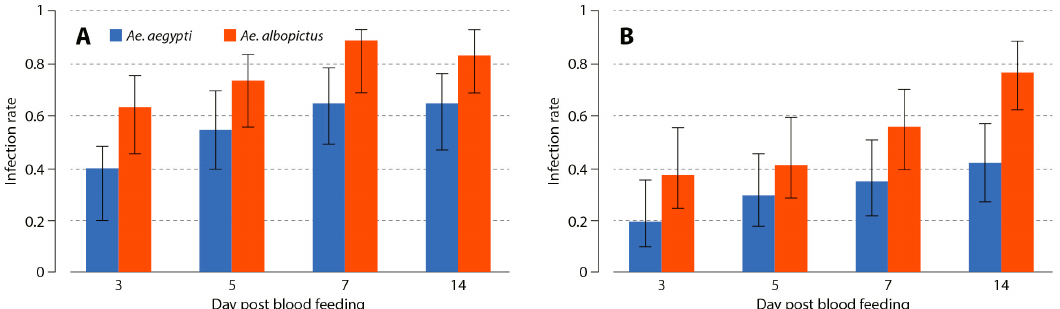
Figure 1. Viral infection rates after oral exposure to Aedes aegypti and Aedes albopictus. Panels ( A ) and ( B ) represent the rate of viral infection across time in the midgut and salivary glands, respectively. Error bars represent the 95% confidence interval.